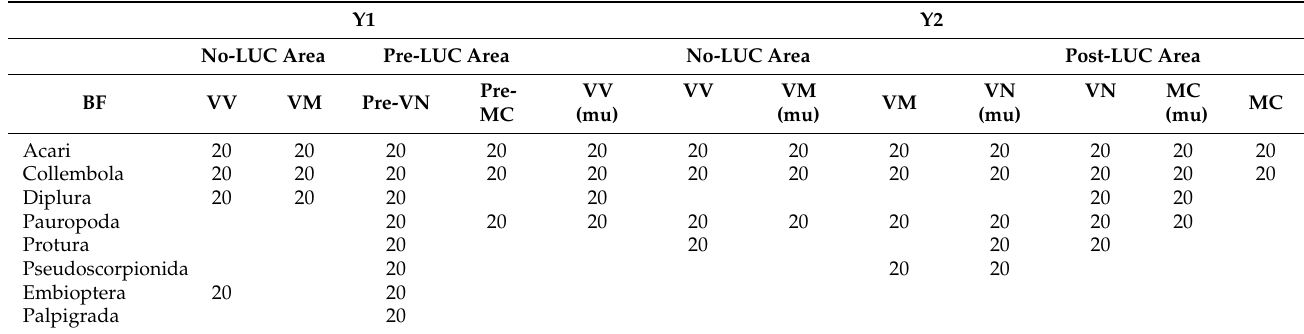
Table A1. EMI values for biological forms (BF) and BSQar indexes calculated by three morpho-functional levels [29] in the first (Y1) and second (Y2) years, in the different areas (no-LUC, LUC), considering mulching (mu) effect.